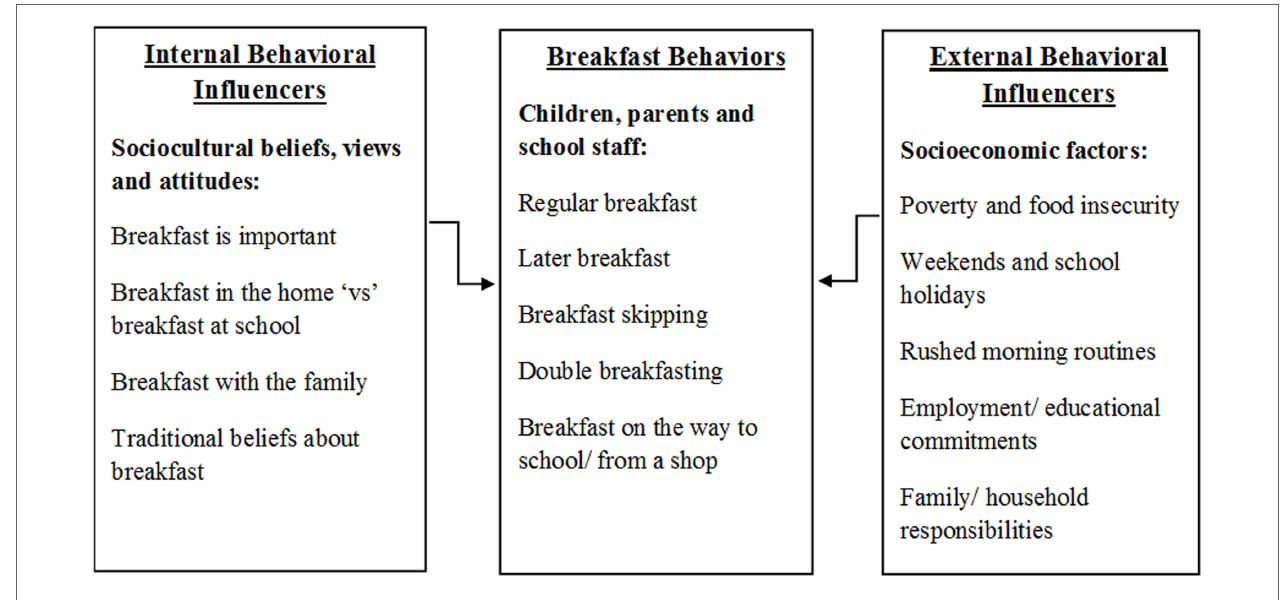
FigUre 1 | Qualitative model for breakfast behaviors